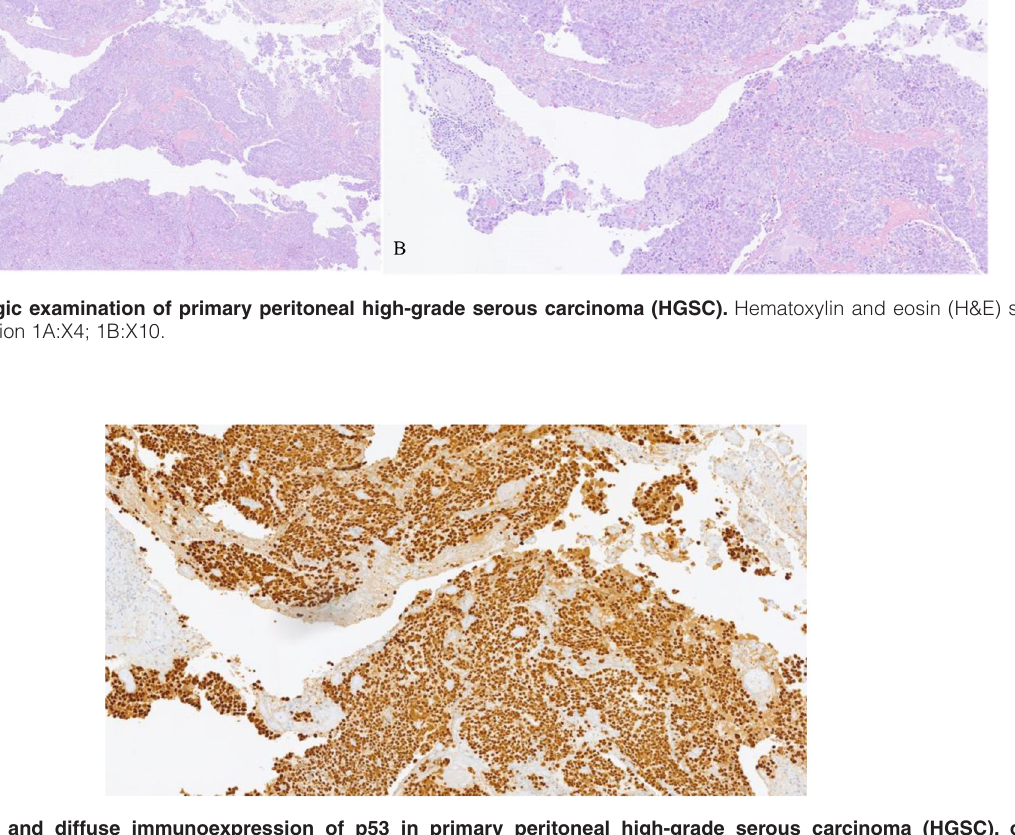
Figure 2. Strong and diffuse immunoexpression of p53 in primary peritoneal high-grade serous carcinoma (HGSC), original magnification